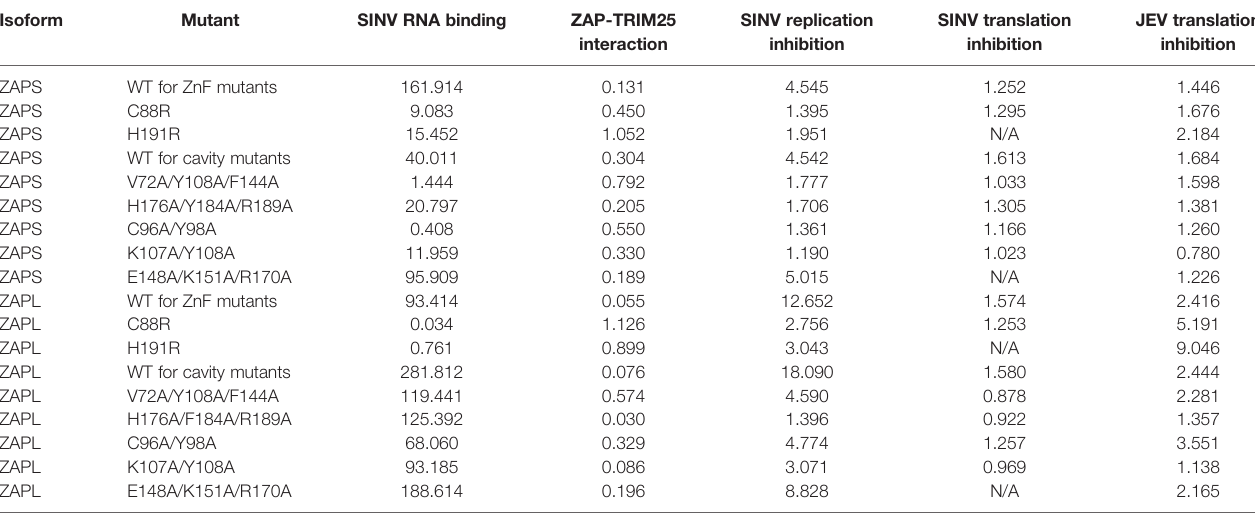
TABLE 1 | Quanti fi ed values for ZAP RNA binding mutant phenotypes. Isoform